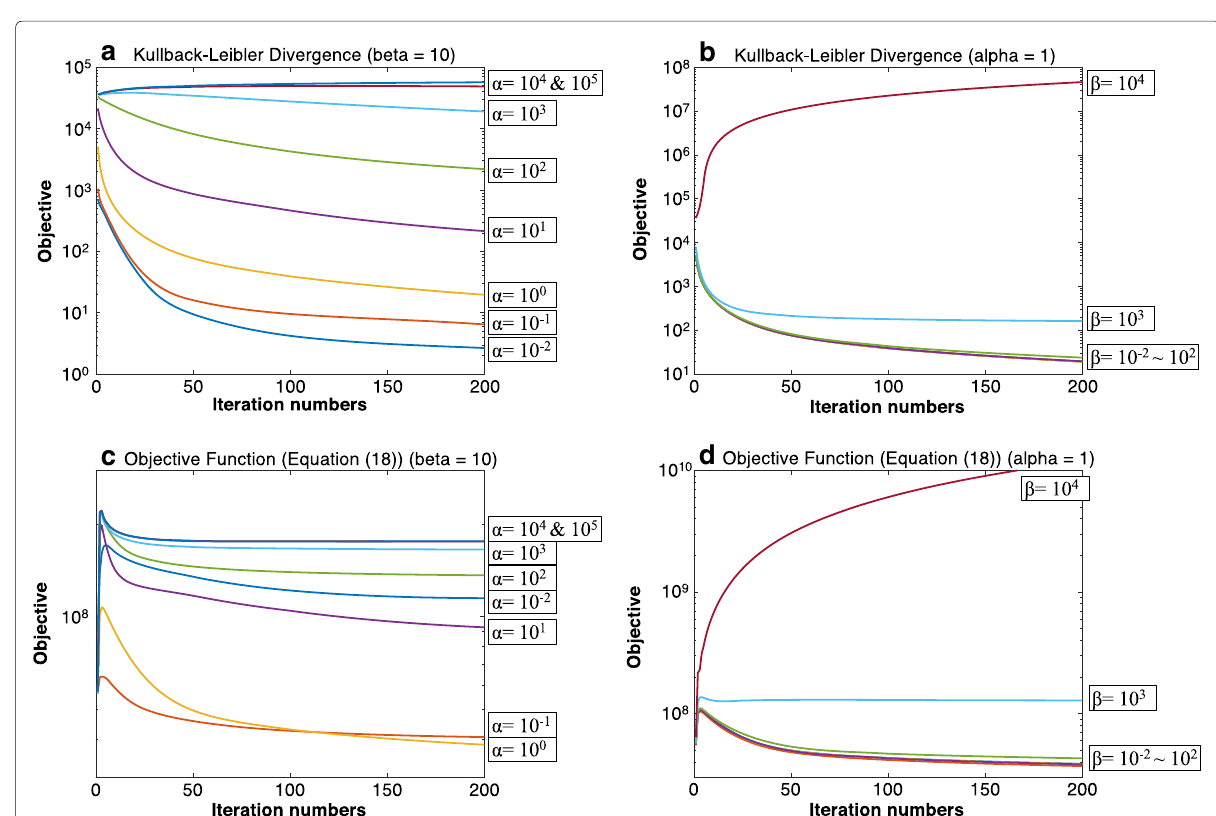
Fig. 12 Objective functions with varying α and β . The values of the objective functions are calculated for a the Kullback–Leibler divergence with β = 10 and varying α , b the Kullback–Leibler divergence with α = 1 and varying β , c Eq. (20) with β = 10 and varying α , and d Eq. (20) with α = 1 and varying